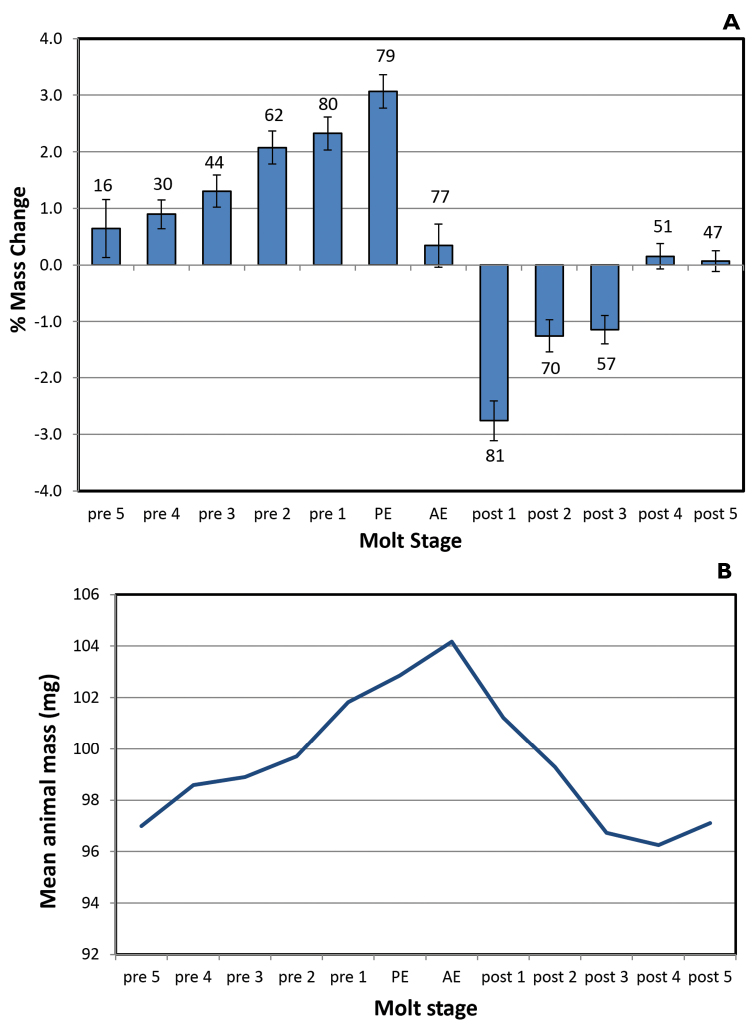
A Mass changes of Armadillidiumvulgare during molting at 100 % RH, without access to food. Pre- and post- labels refer to the number of days before/after ecdysis with data showing the % mass change over the prior 24-h period. PE = posterior ecdysis; AE = anterior ecdysis. Bars show ± SEM with sample sizes B Mean masses of 4 of these animals, showing the characteristic pattern of mass gain, peaking between PE and AE, followed by loss over the 3 to 4-day post-molt period.